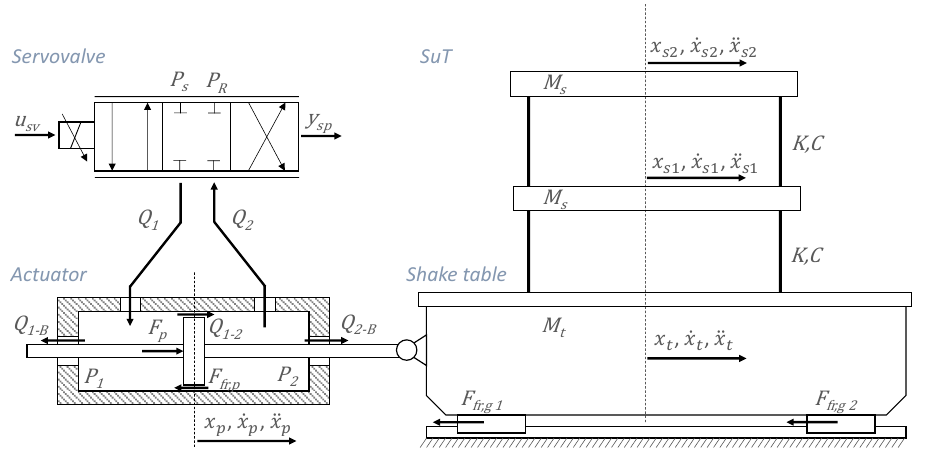
Figure 4. Scheme of the shake table system modeled elements.